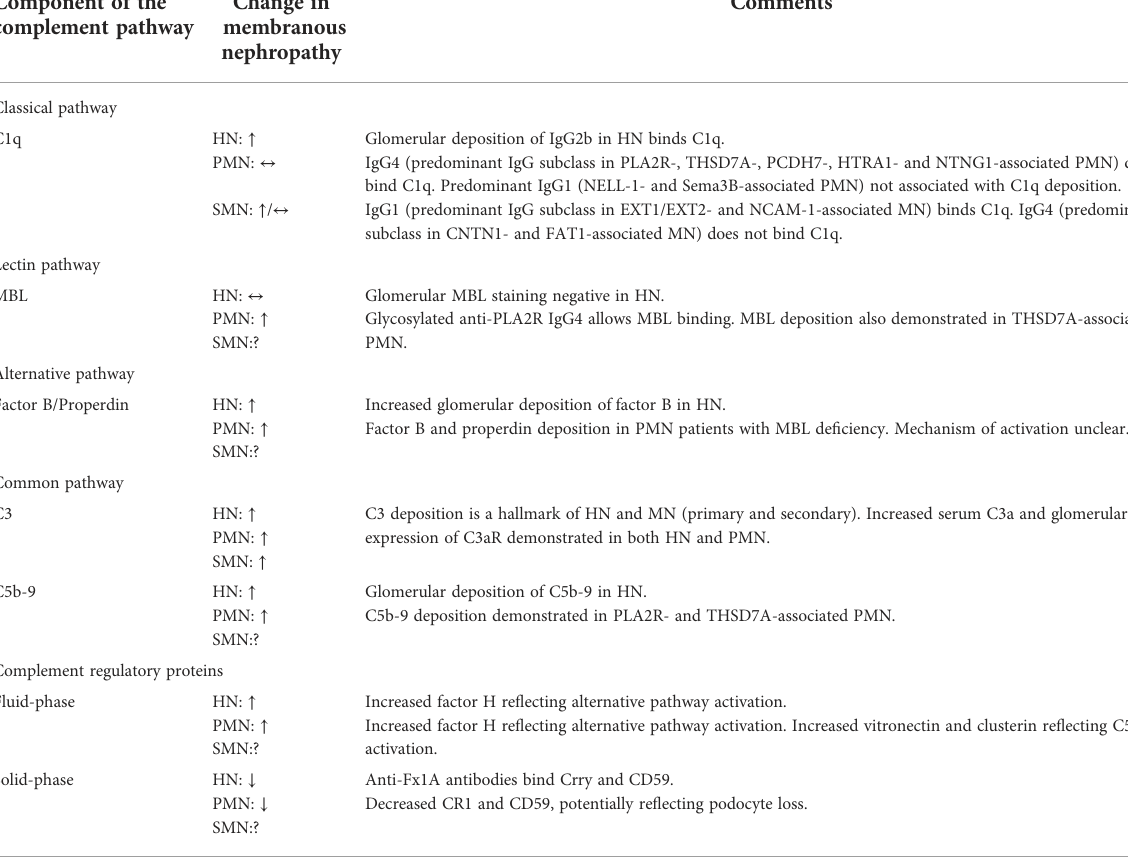
TABLE 2 Complement system involvement in Heymann nephritis and membranous nephropathy. Component of the complement